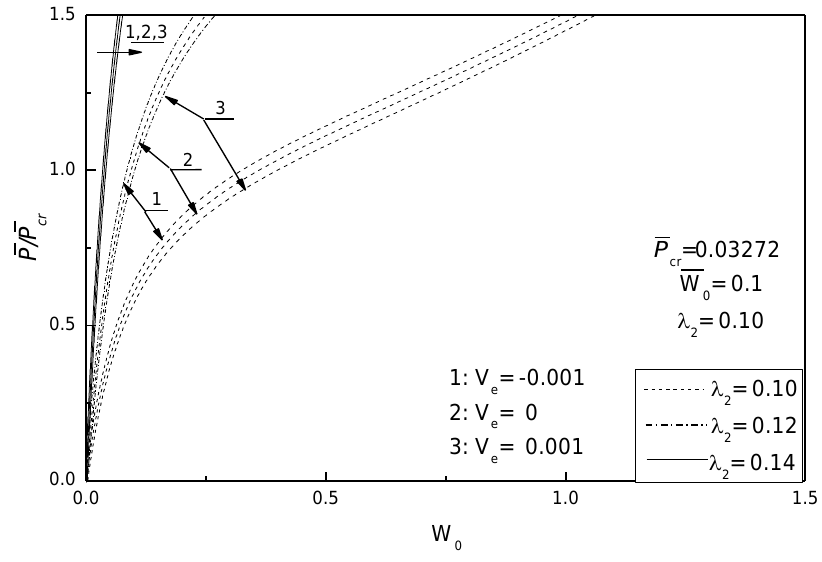
Figure 9. Effect of aspect ratio on postbuckling response curves of piezoelectric plate without damage under different electrical loads.